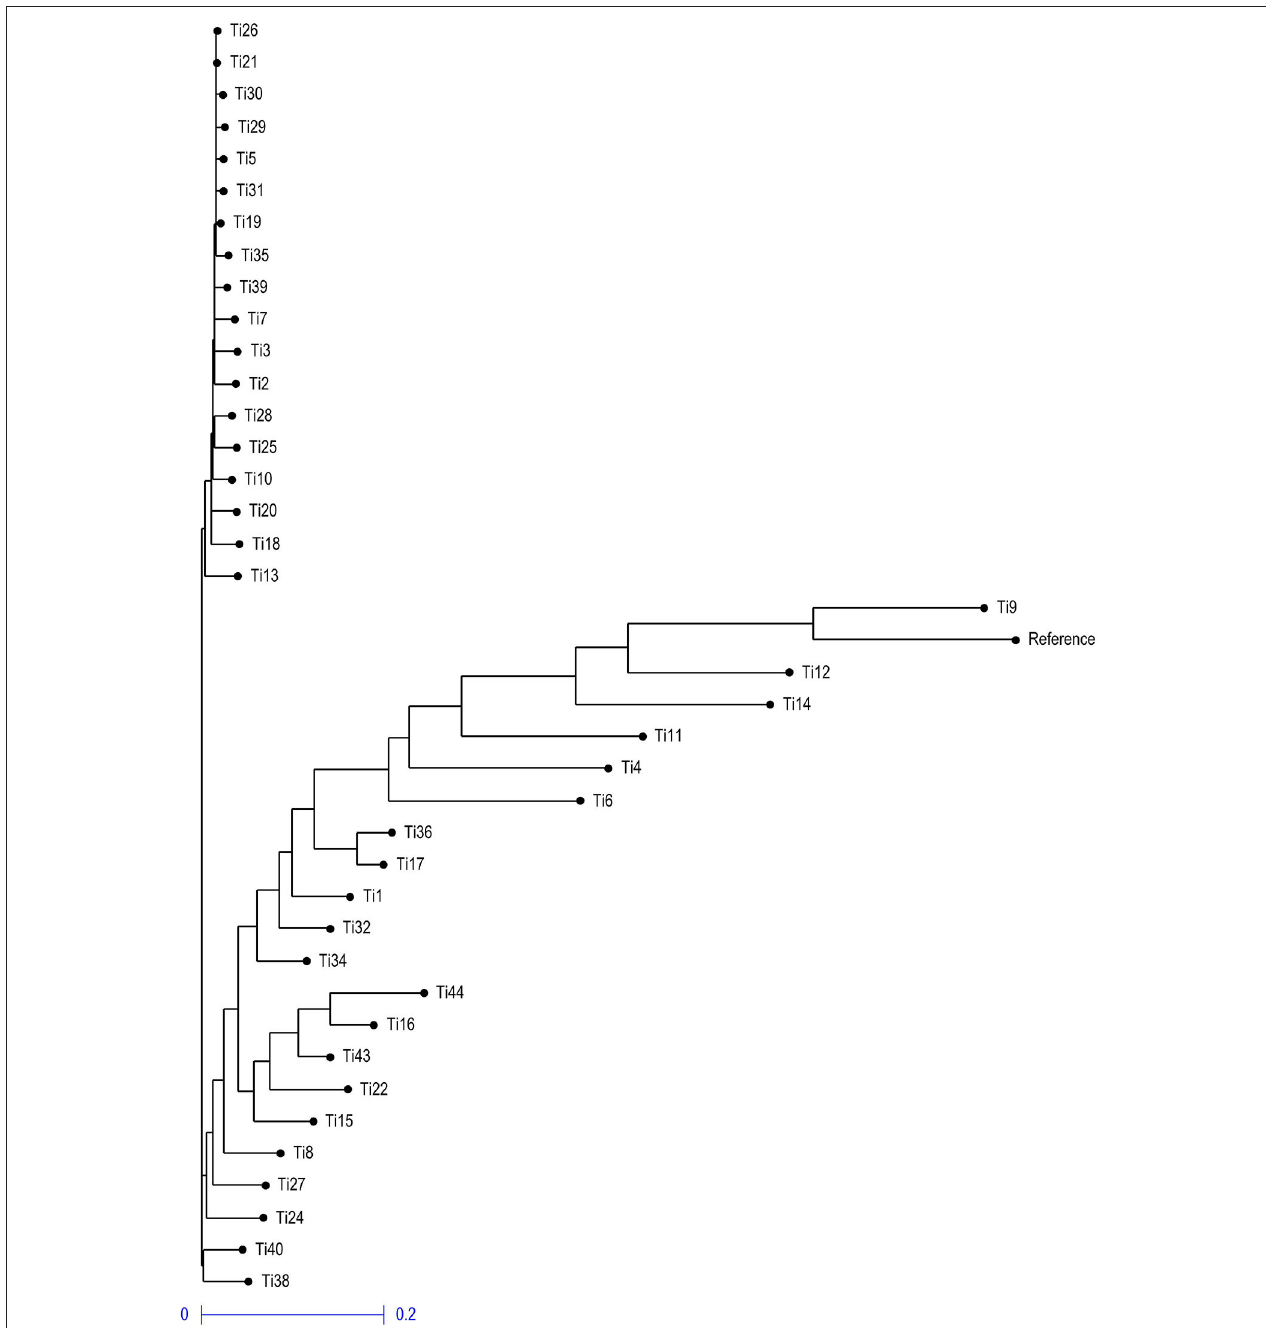
FIGURE 10 | Neighbor-joining phylogenetic tree illustrating the genetic relationship among 39 T. indica based on 41,473 SNPs.